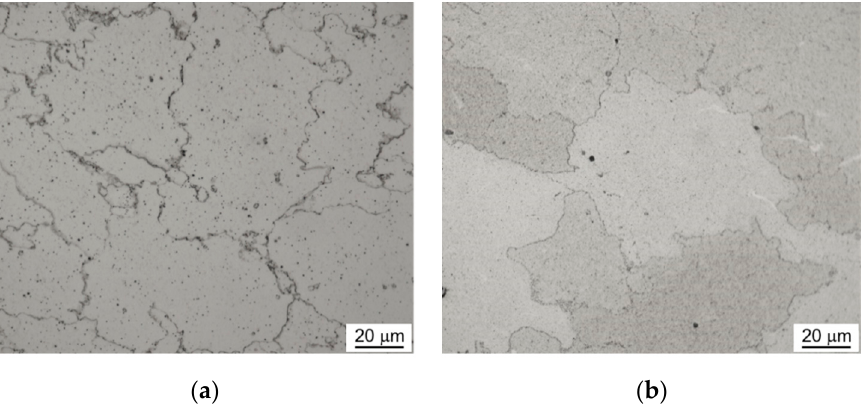
Figure 6. Effect of heat treatment on the microstructure (light microscope) of rolled OP2 ( a ) 1100 °C/20 h and ( b ) 1200 °C/20 h.